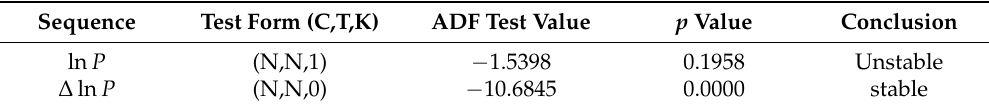
Table 1. The Augmented Dickey-Fuller (ADF) test results.